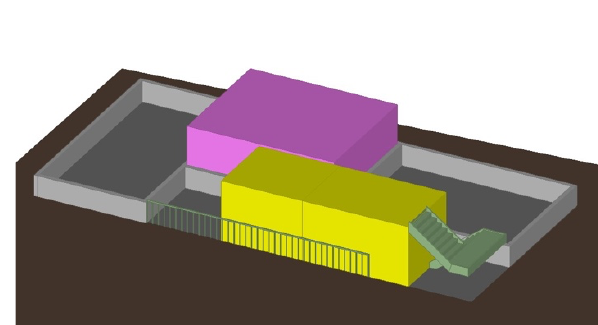
Figure 8. Ground Floor Unit 2 Legal Boundary.